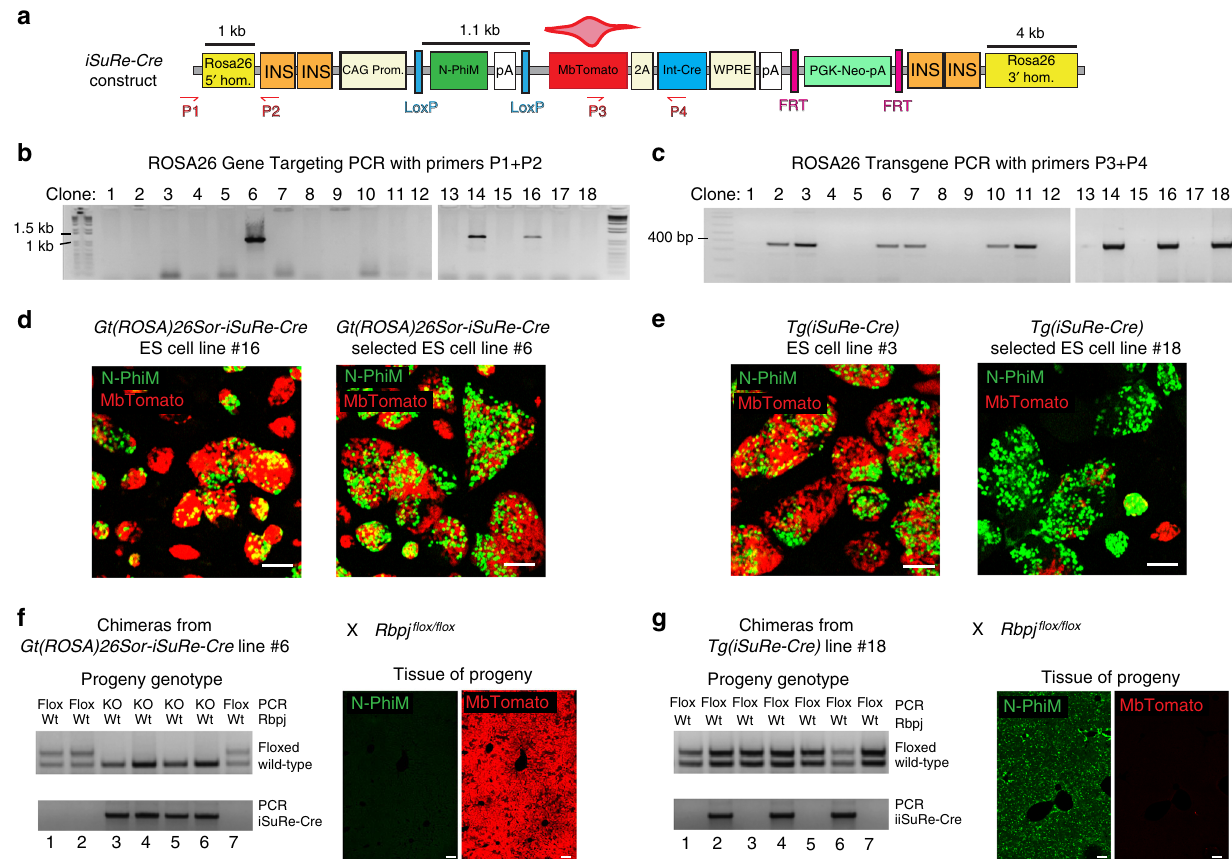
Fig. 2 iSuRe-Cre DNA construct, ES cells, and mice. a iSuRe-Cre DNA construct used to produce gene-targeted or transgenic ES cells and mice. ROSA26 hom., ROSA26 locus homology arms; INS, chicken β -globin HS4 insulator sequence; FRT, short DNA sequences recognized by the recombinase Flp allowing deletion of the PGK-Neo selection cassette; P1-P4, primers used to genotype ES cells or mice. For further abbreviations and their de fi nitions see also Fig. 1c legend. b PCR result with primers detecting the integration of the vector in the ROSA26 locus of ES cell clones 1 – 18. c PCR result with primers detecting the presence of the iSure-Cre allele in the genome of ES cells 1 – 18. d Representative images of different ROSA26-targeted (Gt(ROSA)26Sor) ES cell clones at baseline. N-PhiM is expressed if the allele is non-recombined, and MbTomato marks cells that had recombination of the construct without induction. Clone #6 has a higher proportion of non-recombined N-PhiM + cells. e Representative images of different Tg(iSuRe-Cre ) ES cell clones at baseline. Clone #18 has a higher proportion of non-recombined N-PhiM + cells. f Mouse chimeras generated with Gt(ROSA)26Sor-iSuRe-Cre ES cell clone #6 were interbred with Rbpj fl ox/ fl ox animals, and the progeny were genotyped for the Rbpj and iSuRe-Cre alleles. All animals containing the iSuRe-Cre allele in the ROSA26 locus had deletion of the Rbpj - fl oxed allele and expressed the MbTomato reporter in all cells. g Mouse chimeras generated with Tg(iSuRe-Cre) ES cell clone #18 were interbred with Rbpj fl ox/ fl ox animals, and the progeny were genotyped for the Rbpj and iSuRe-Cre alleles. Animals containing the Tg (iSuRe-Cre) allele did not have deletion of the Rbpj- fl oxed allele and did not express the MbTomato reporter. Instead they expressed the N-PhiM reporter due to the absence of Cre activity. Scale Bars 100 μ